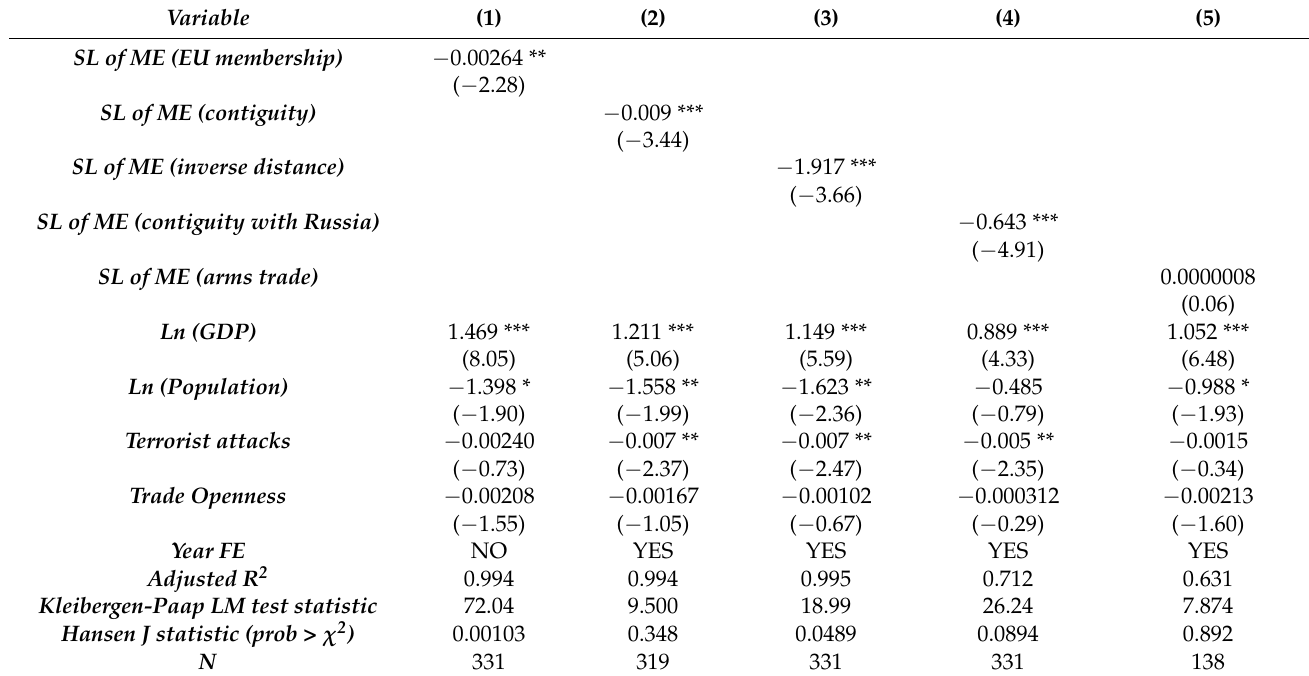
Table 2. EU military expenditure,